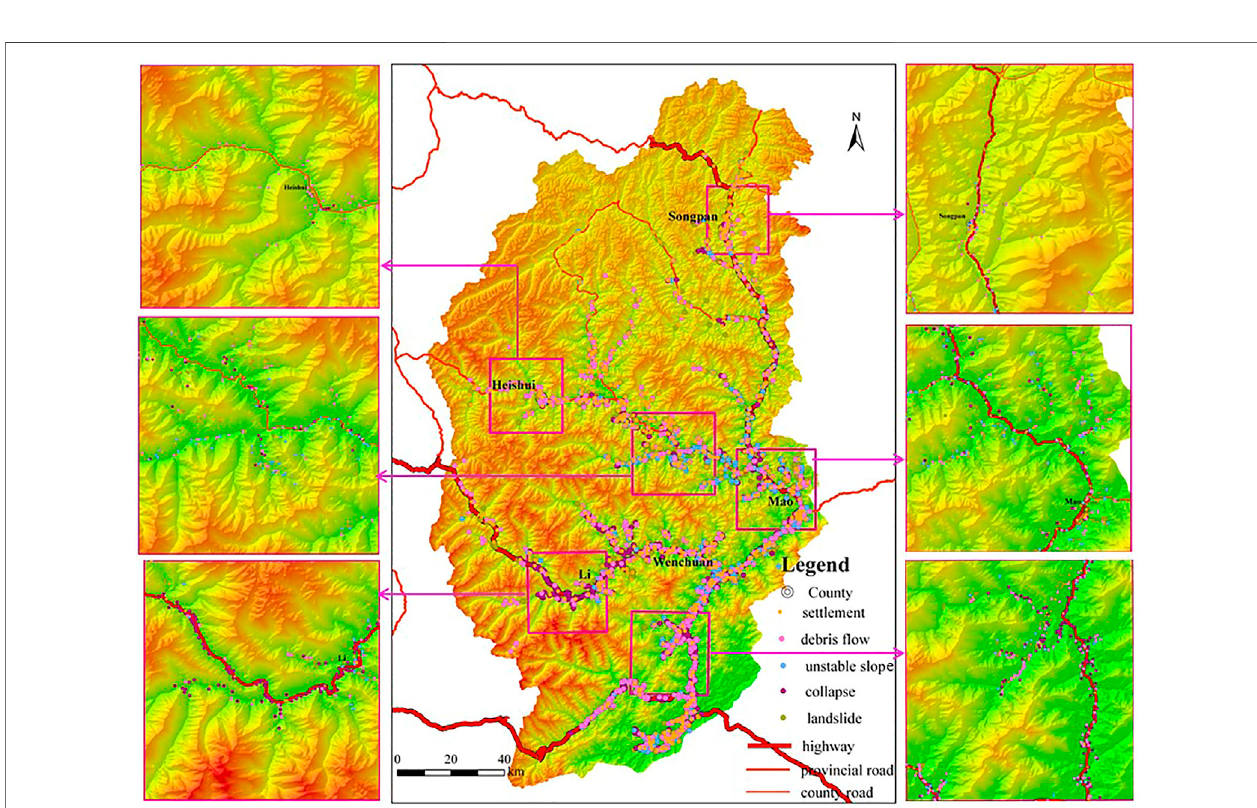
FIGURE 6 | The distribution of collapses, unstable slopes, landslides, debris fl ows, and settlements in the upper reaches of the Min River.